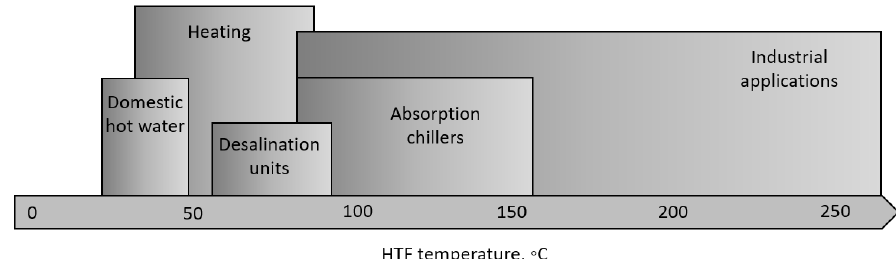
Figure 4. Applications of heat extracted from CPVT system depending on its